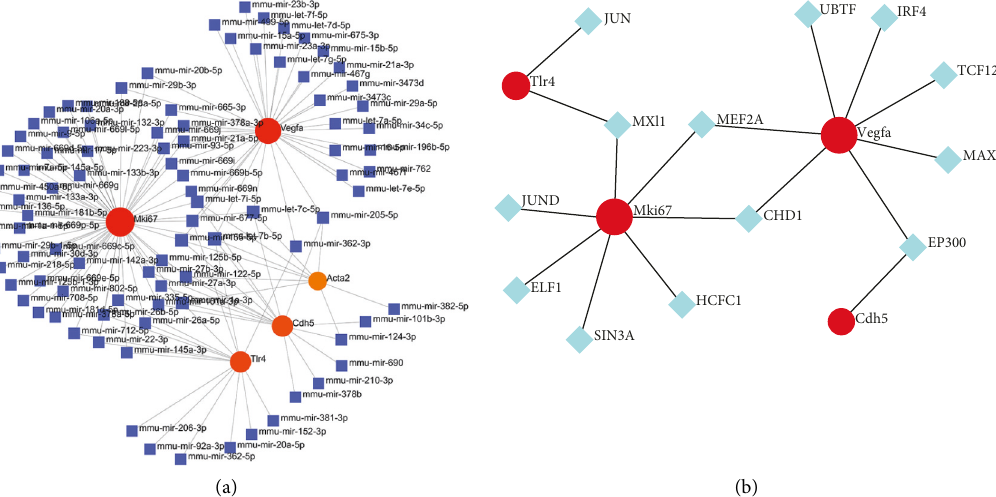
Figure 8: The networks of (a) miRNA-gene and (b) TF-gene. The red circle nodes are the genes, the blue square nodes are the miRNAs, and the green diamond nodes are the TFs.